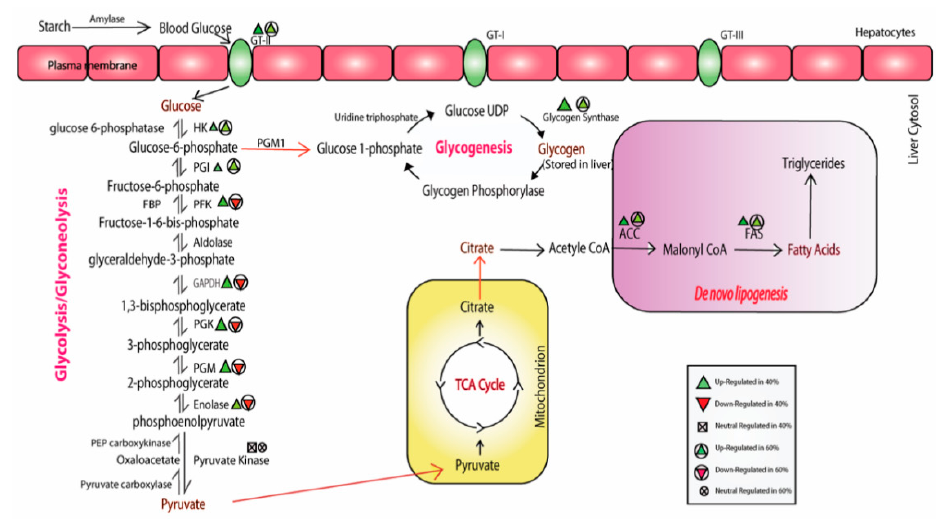
Figure 6. Up-regulation and down-regulation of key metabolic genes in hepatocytes.